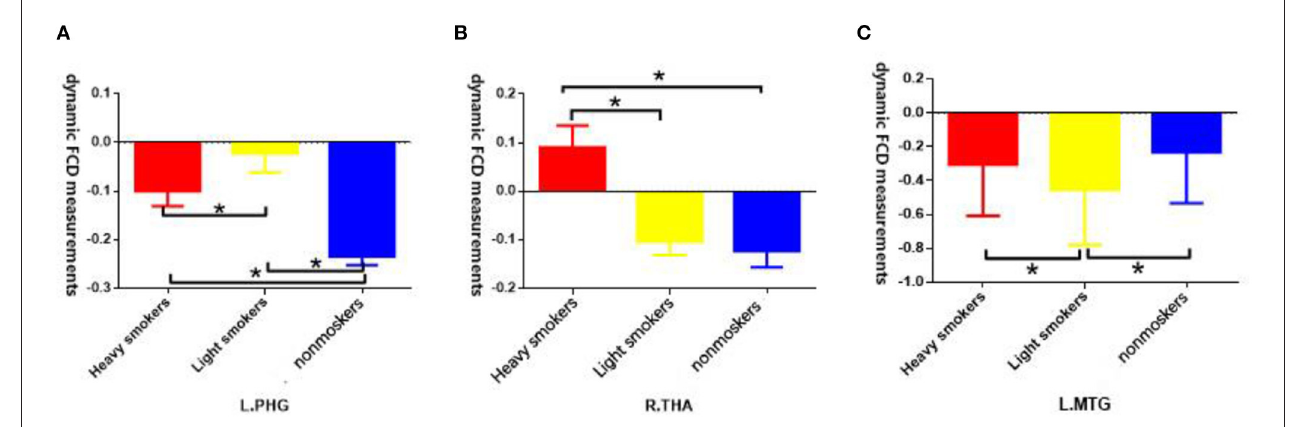
FIGURE 3 | (A) Both heavy smokers and light smokers showed significant alternations of dFCD measurements in left parahippocampal gyrus, significant differences have been found between heavy smokers and light smokers; (B) Heavy smokers showed significant alternations of dFCD measurements in right thalamus compared with nonsmokers, significant differences have been found between heavy smokers and light smokers; (C) Light smokers showed significant alternations of dFCD measurements in left middle temporal gyrus (MTG) compared with nonsmokers, significant differences have been found between heavy smokers and light smokers. * means difference between the two groups has statistical